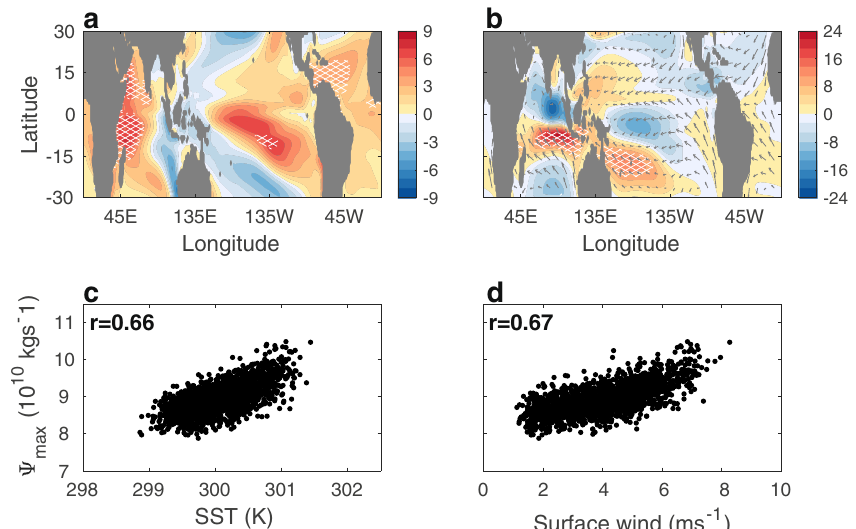
Fig. 5 Linking surface winds and SST to the SH Hadley cell strength. The regression of ( a ) SST (K, colors) and ( b ) surface wind vector (ms − 1 , colors) onto SH Ψ max normalized by its climatological value. Hatching shows where the SST/surface winds are linked to Ψ max (i.e., with R 2 ≥ 0.3). The arrows in panel b show the mean surface winds from the FULL run. SH Ψ max plotted against ( c ) SST in the Southwest Indian Ocean (K) and ( d ) surface winds in the Southeast Indian Ocean (ms − 1 ) from the FULL run. Correlations are shown in the top left